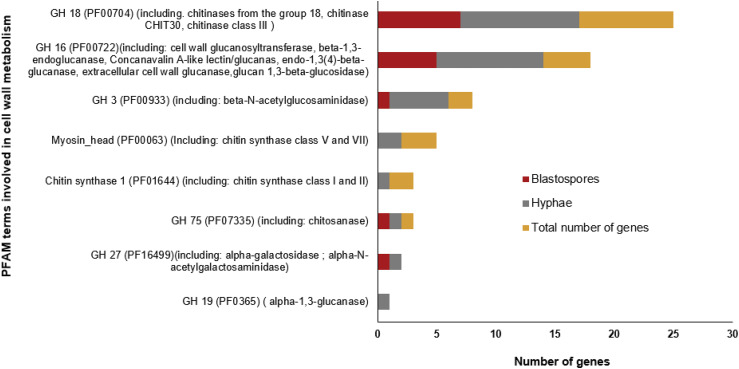
Number of genes with PFAM terms involved in cell wall metabolism. Up-regulated genes are represented by dark red bar for blastospores and gray bars for hyphae, FDR-pvalue < 0.001 (Additional file 6).